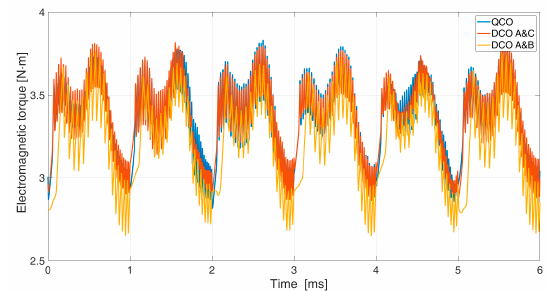
Figure 12. Waveforms of electromagnetic torque—variant II.